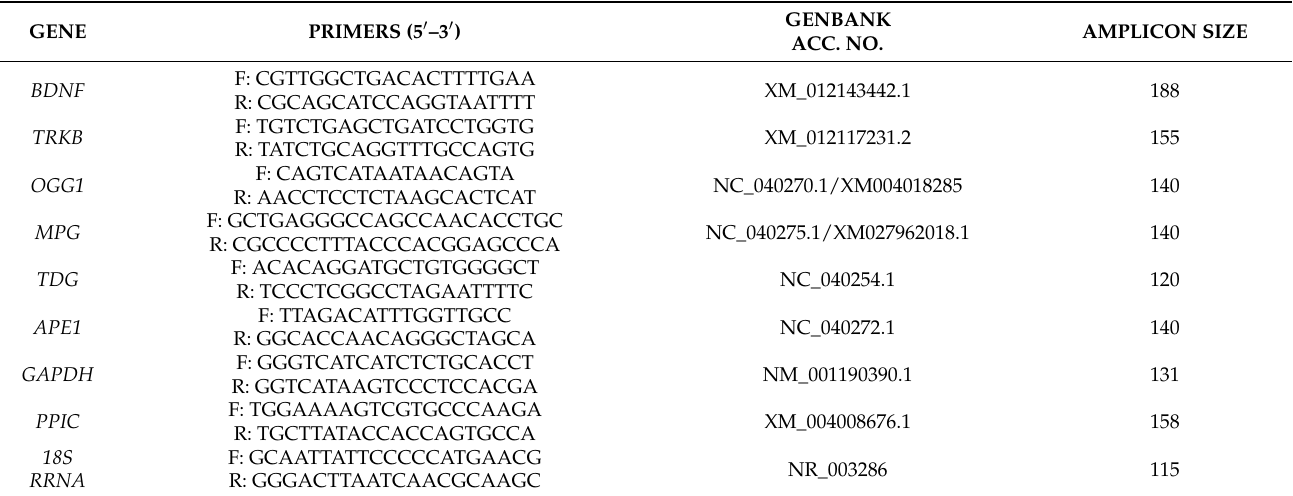
Table 1. Sequences of specific